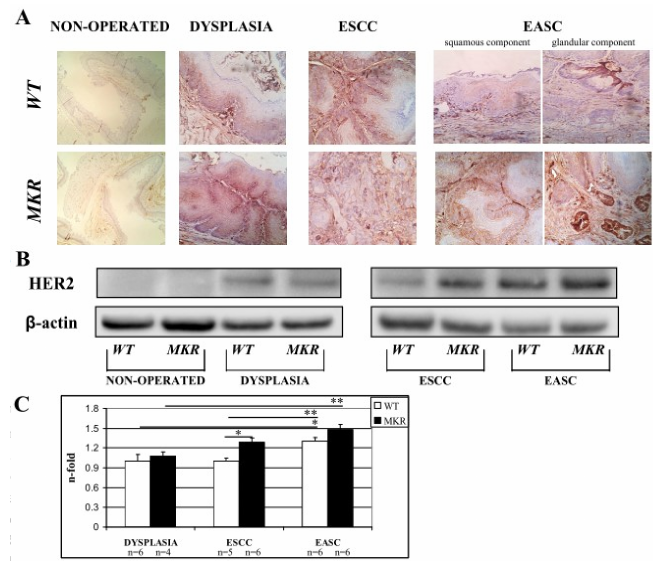
Figure 7. Representative case of HER2 overexpression detected by Immunohistochemistry IHC ( A ) and Western blotting ( B ). ( A ) WT (wild-type mouse esophageal tissue). From left to right: 1. Non-operated (healthy tissue) WT female at 43 weeks of age (IHC negative; original magnification 100 × ). 2. Squamous Dysplasia (LGD/HGD) in WT male (IHC2+; original magnification 200 × ). 3. ESCC in WT male (IHC3+ on both dysplastic and infiltrative component; original magnification 200 × ). 4. EASC in WT male (IHC2+ in squamous component and IHC1+ in glandular component; original magnification 200 × ). MKR (MKR mouse esophageal tissue). From left to right: 1. Non-operated (healthy tissue) MKR female at 43 weeks of age (IHC negative; original magnification 100 × ). 2. Squamous Dysplasia (HGD) in MKR female (IHC3+; original magnification 200 × ). 3. ESCC in MKR female (IHC2+; original magnification 200 × ). 4. EASC in MKR male (IHC3+ in both squamous and glandular component;